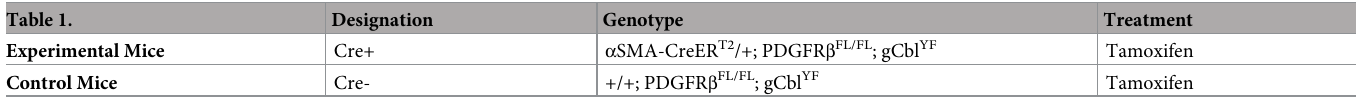
Table 1. Genotypes of mice used for in vivo fracture experiments. Table